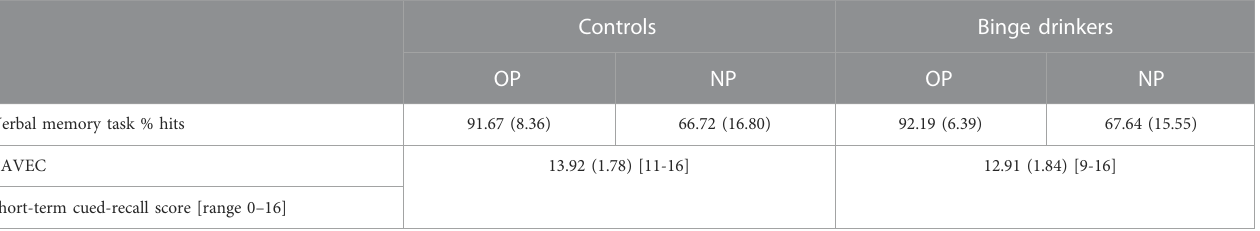
TABLE 6 Descriptive statistics on the behavioural measures. Percentage of hits in the verbal paired associates task (old and new word pairs, OP/NP) and scores in the Short-term cued-recall measure of the TAVEC. Mean (standard deviation) for each